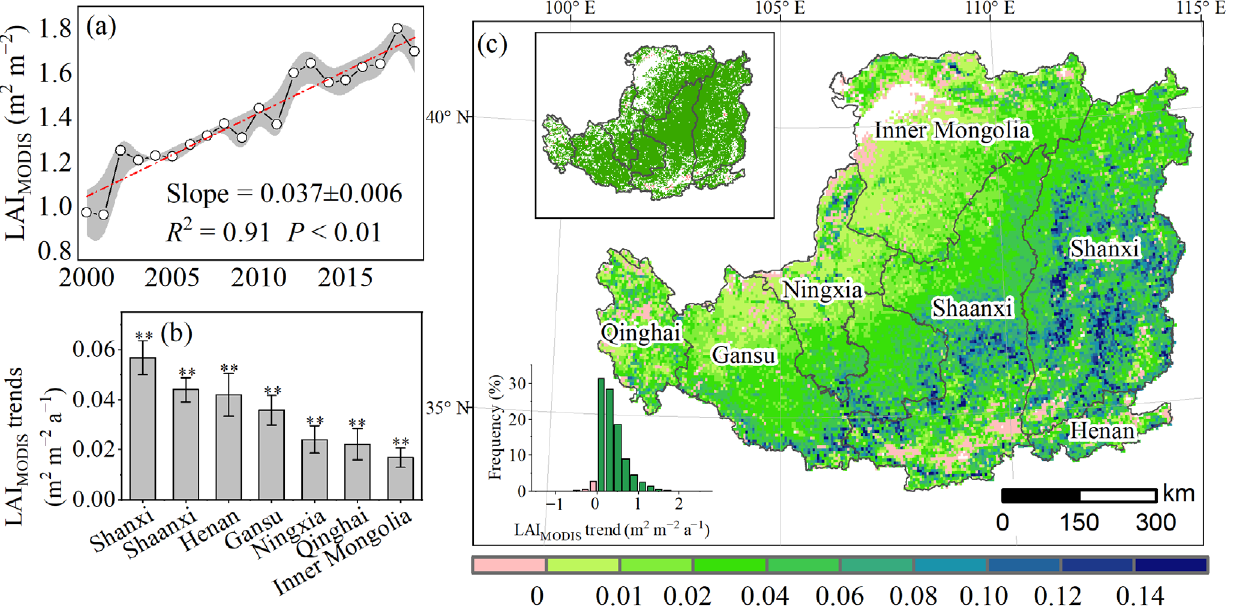
Figure 3. The interannual trend of LAI MODIS on the Loess Plateau During 2000–2019. ( a ) The interannual variations in LAI MODIS on the Loess Plateau; ( b ) the interannual variation in LAI MODIS for each province of the Loess Plateau (** represents P < 0.01); ( c ) spatial distribution of LAI MODIS trends. The inset map at the top-left corner shows the significant increasing (green) or decreasing trend (blue) in LAI MODIS during the study period; the inset graph at the bottom-left corner describes the frequency distribution of satellite-based LAI MODIS trends.